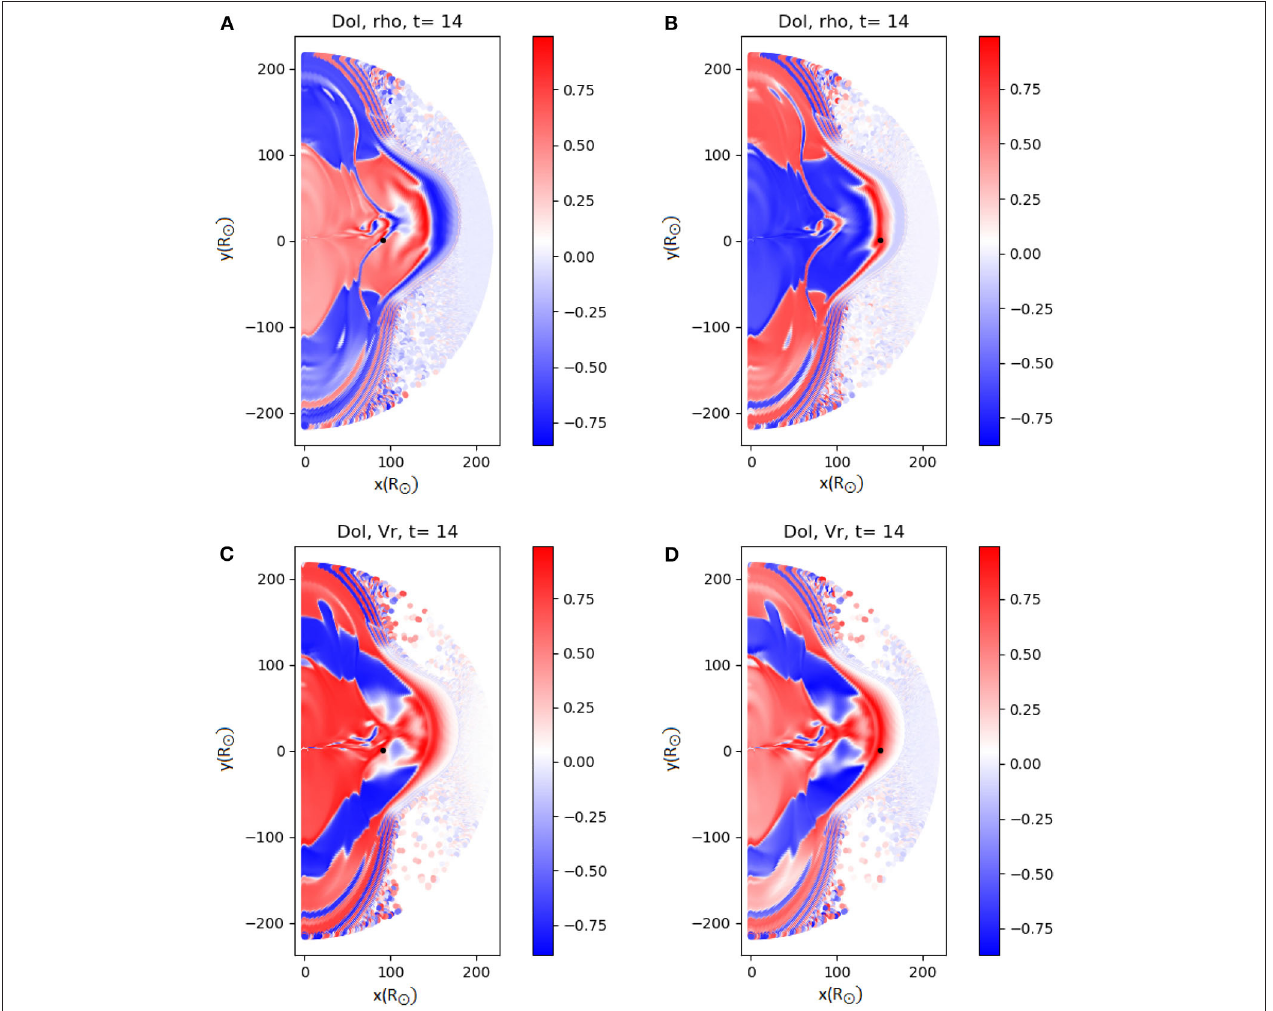
FIGURE 12 | DOI maps for the density (A,B) and the radial velocity (C,D) , computed from PLUTO simulation ensembles. The first column has a detection point at R = 90 R ⊙ and the second column at R = 150 R ⊙ (marked by the black dot). In this set we perturb two parameters, the radial velocity and the size of the